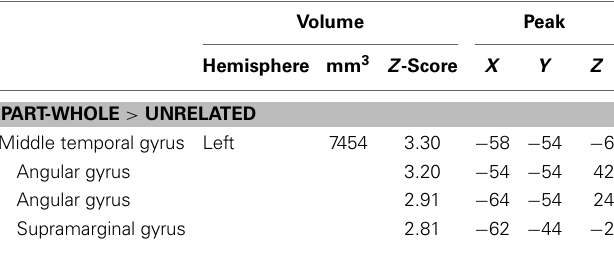
Table 2 | Part-whole comparisons—areas of activation with sub-peaks.